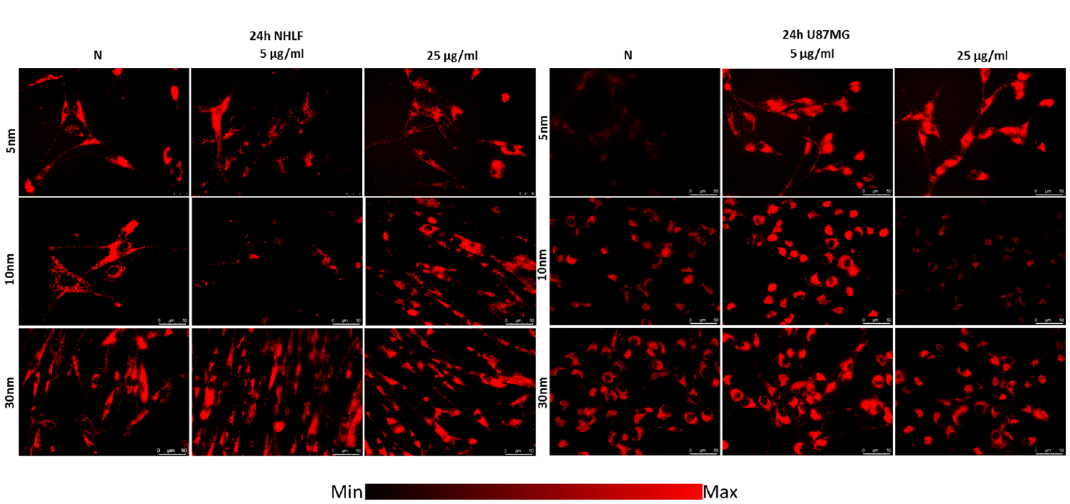
Figure 8. Microscopic images of NHLF and U87MG cells presenting ROS levels after 24 h of exposure to IONPs with 5 nm, 10 nm and 30 nm diameters in concentrations of 5 µg Fe/ml and 25 µg Fe/ml compared with control group